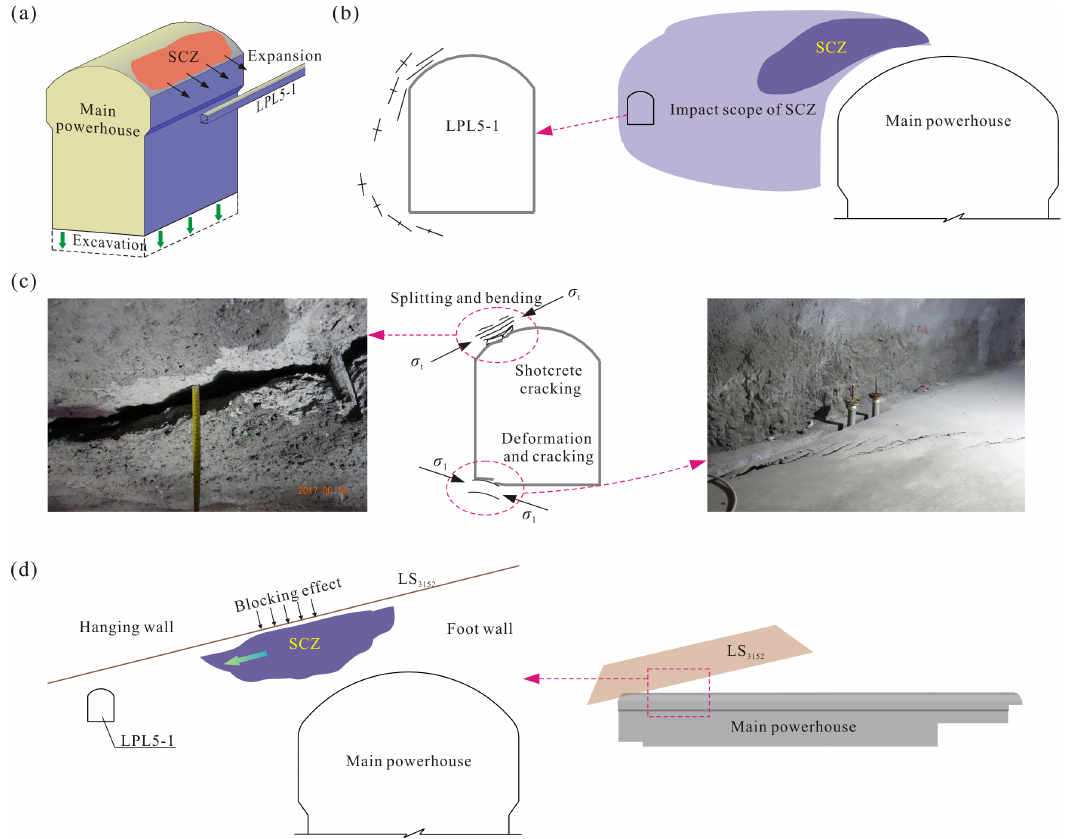
Figure 11. Failure mechanism in the drainage gallery LPL5-1: ( a ) stress evolution induced by the excavation of the main powerhouse, ( b ) stress distribution in surrounding rock mass, ( c ) mechanism of shotcrete and floor concrete cracking in LPL5-1 and ( d ) stress adjustment under the influence of the internal shear